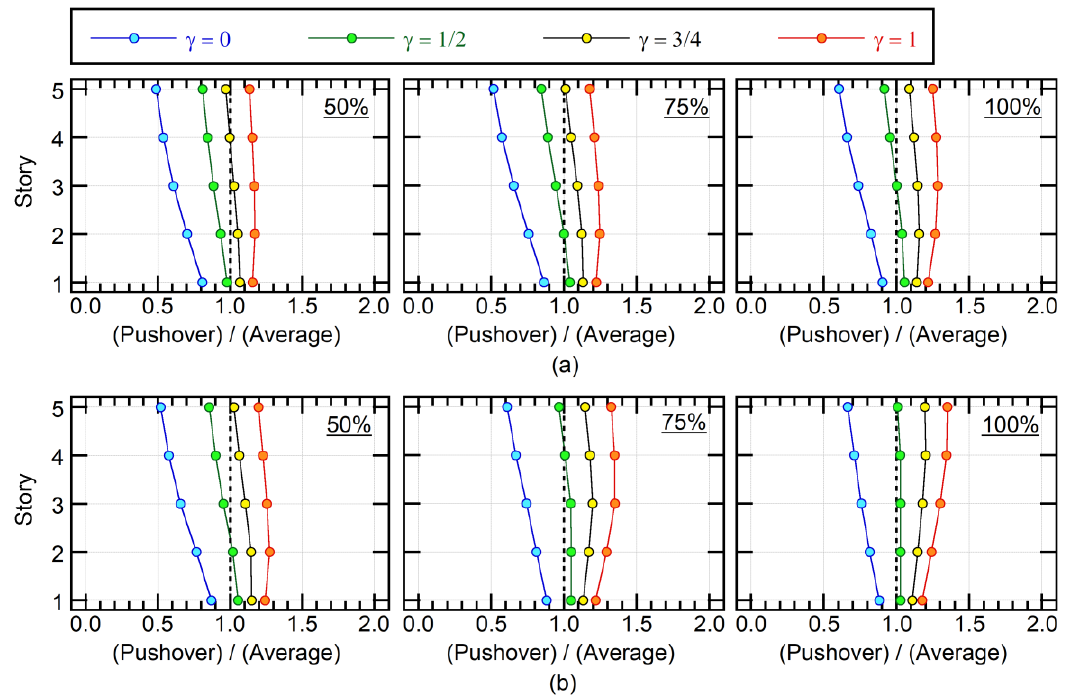
Figure 23. Accuracy of the pushover analysis results in comparison with the average values of time-history analysis (Model-05, shear force of column X 2 Y 2 ): ( a ) Art-S series and ( b ) Art-L series.